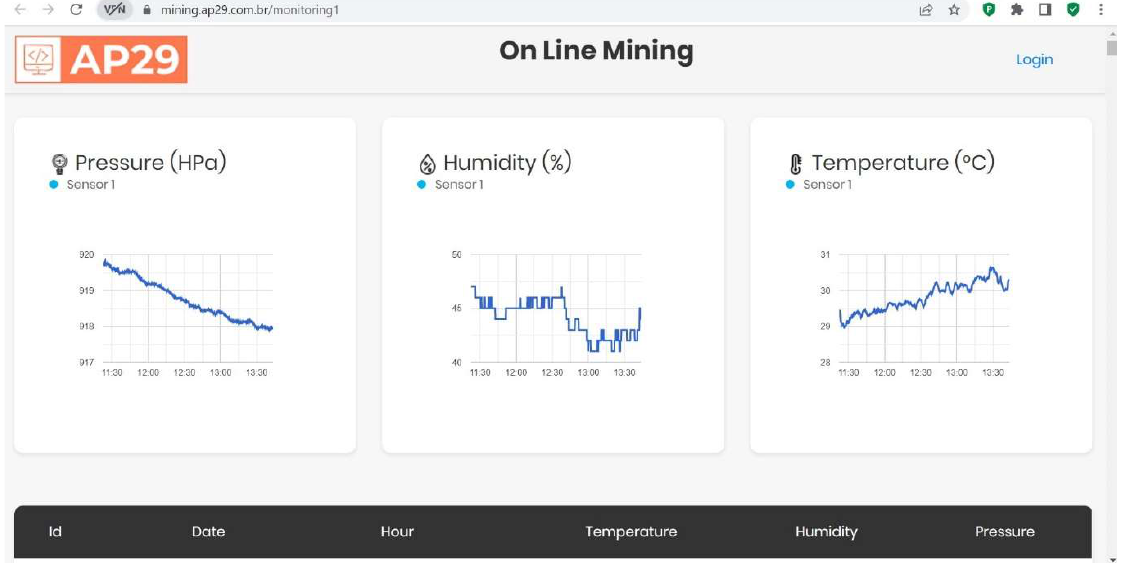
Figure 8. Website showing the measurement readings by the wearable monitoring device.